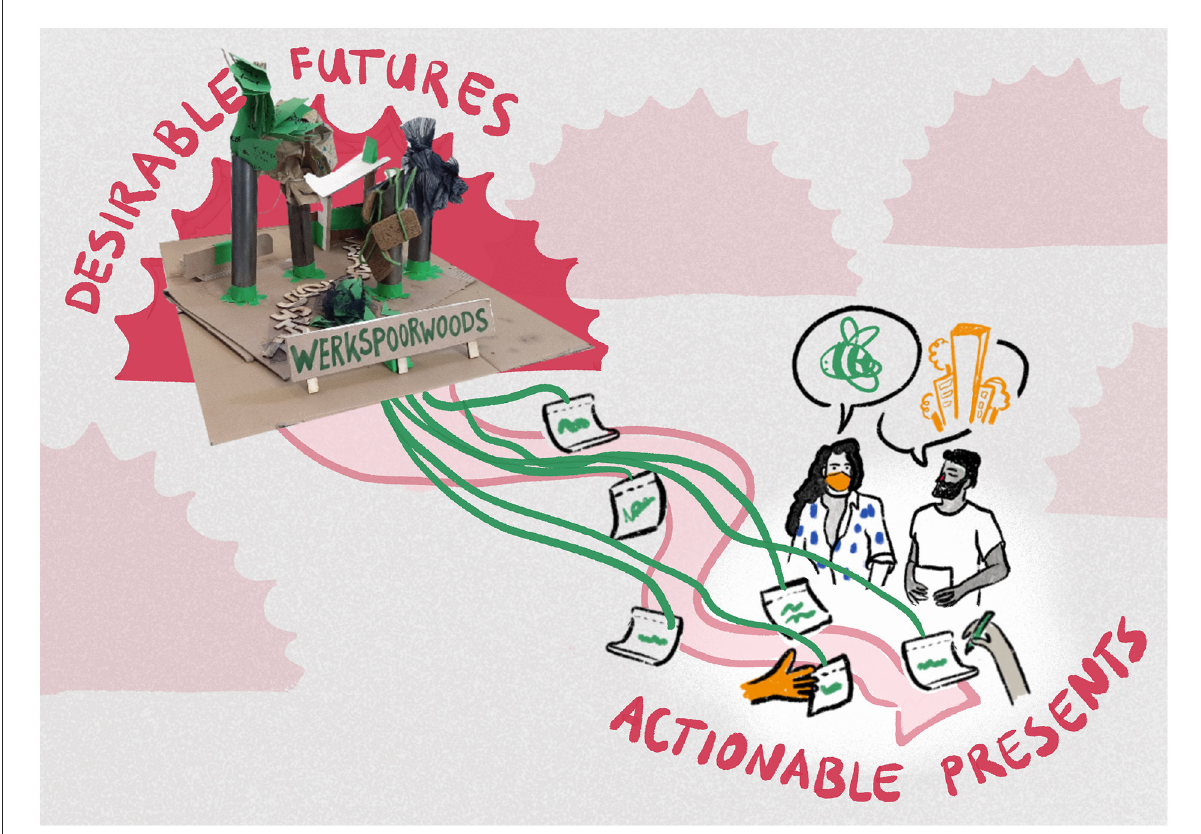
FIGURE11 Translation as vision-making: From desriable futures to actionable